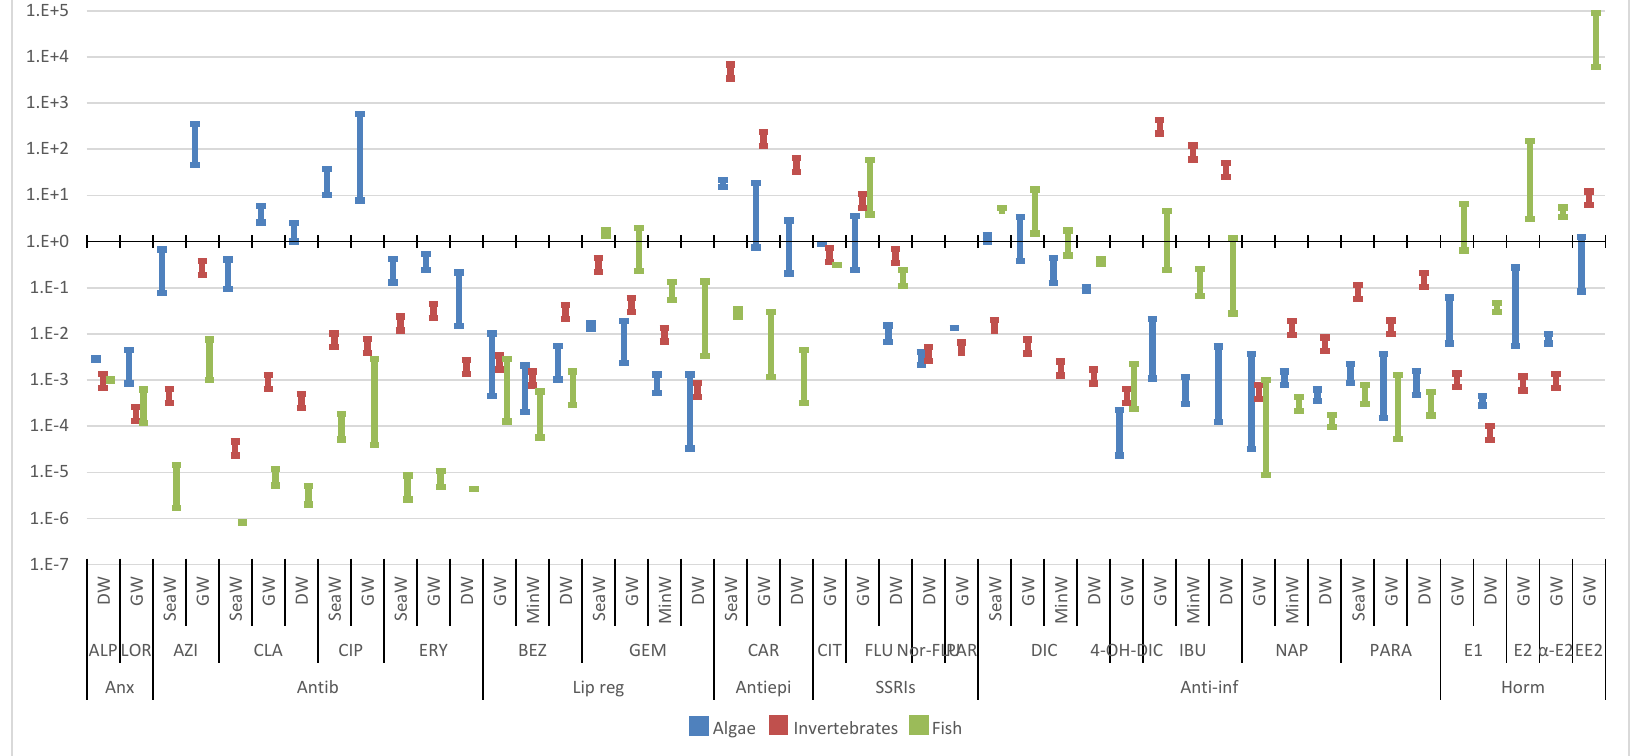
Figure 7. Median and maximum risk quotients of pharmaceuticals in other water bodies for the three trophic levels. (DW—drinking water; GW groundwater; SeaW—seawater; MinW—mineral water; Anx—anxiolytics; Antib—antibiotics; Lip reg—lipid regulators; Antiepi—antiepileptics; SSRIs—Selective serotonin reuptake inhibitors; Anti-inf—anti-inflammatories;